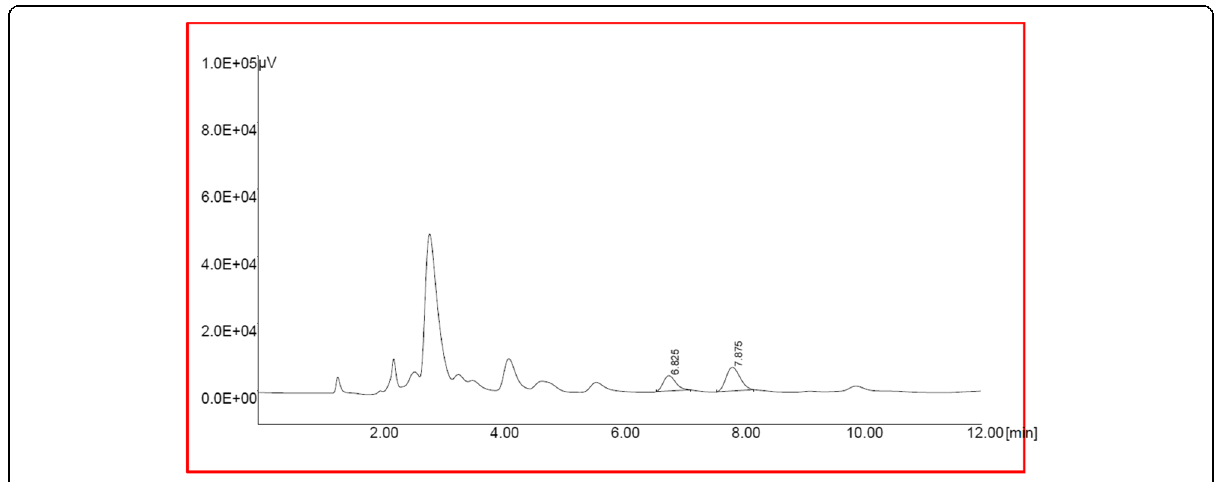
Fig. 3 Representative chromatogram of MCQ sample of chlorthalidone ( R T = 6.825 min) and internal standard ( R T = 7.785 min)